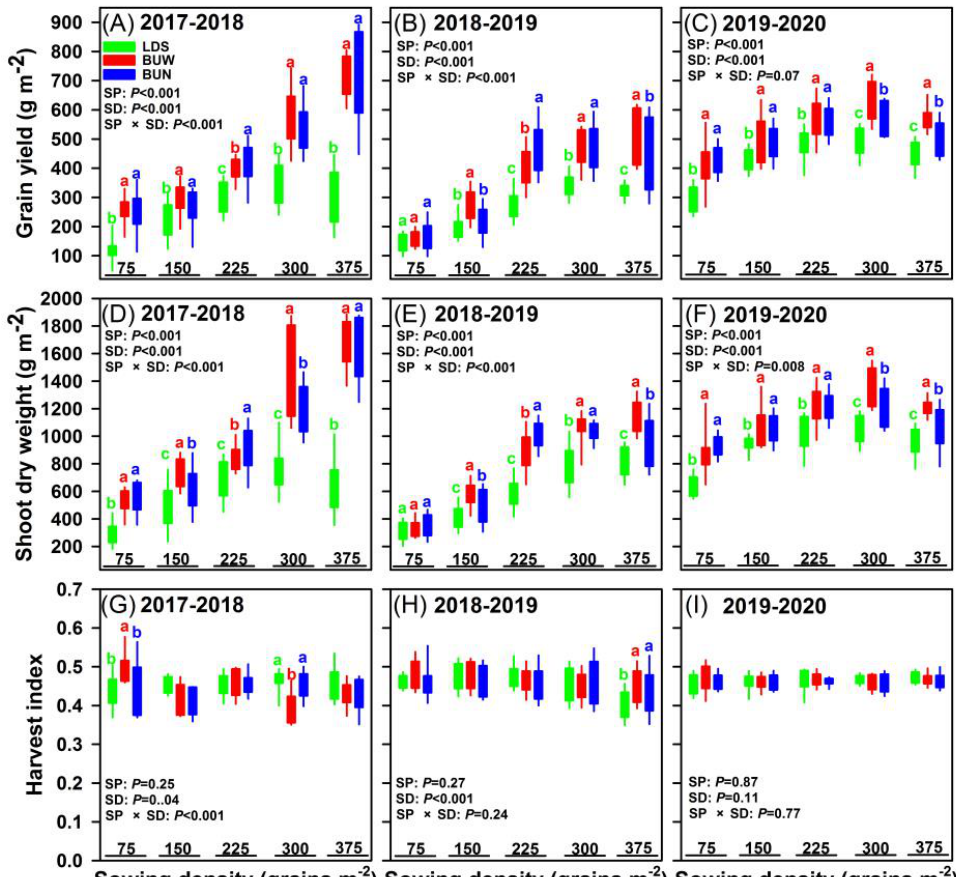
Figure 2. The changes of the ( A – C ) grain yield (g m − 2 ), ( D – F ) shoot dry weight (g m − 2 ), and ( G – I ) harvest index under three sowing patterns (SP; line and dense sowing with 33.3 cm row spacing (LDS); belt uniform sowing with 20 cm row spacing (BUW); and belt uniform sowing with 15 cm row spacing (BUN)) and five sowing densities (SD; 75, 150, 225, 300, and 375 plants m − 2 ) in the three consecutive growing seasons. The different letters mean significant difference between the sowing patters at the same sowing density.